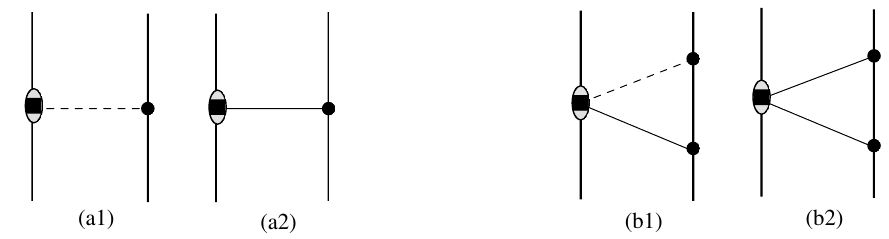
Figure 5 . The extra Feynman graphs of one- and two-graviton exchange, which appear at the NLO cubic-in-spin interaction at the 4.5PN order for maximally-rotating compact objects. The graphs should be included together with their mirror images, i.e. with the worldline labels 1 ↔ 2 exchanged. These graphs contain a new type of worldline-graviton couplings, which we refer to as “composite” octupole ones, and obviously yield similar graphs to the corresponding ones with the “elementary” spin-induced octupole couplings in figure 2(a1),(a2) and in figure